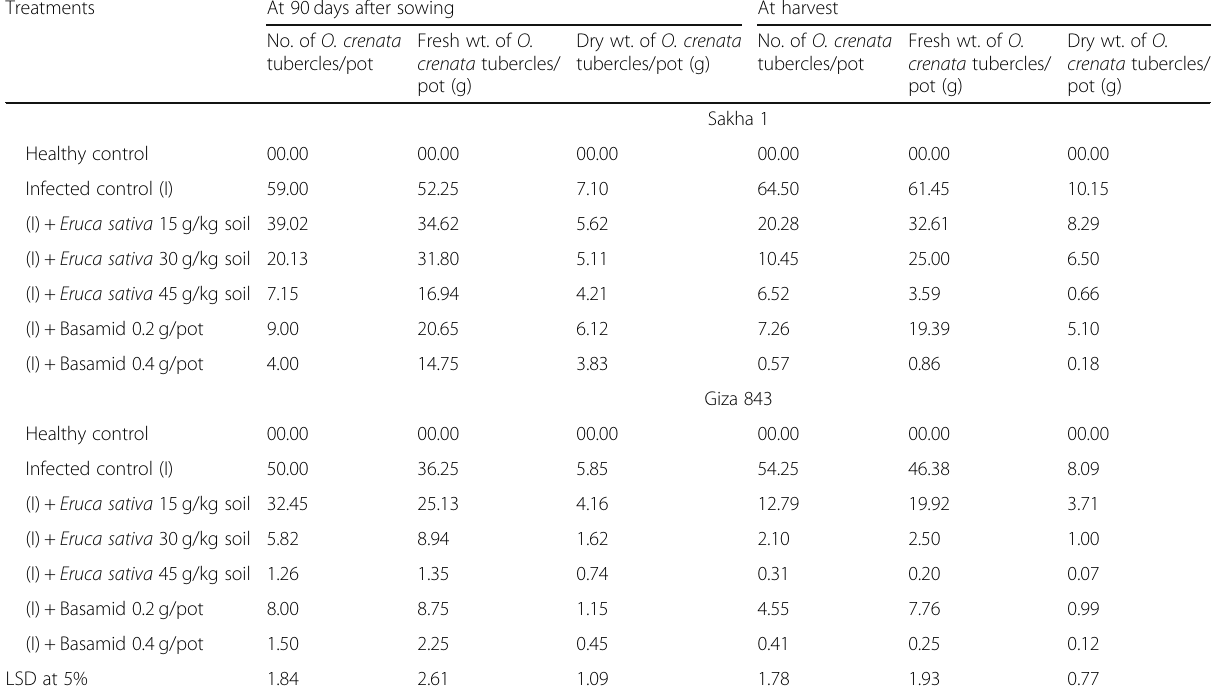
Table 1 Effect of different concentrations of Eruca sativa L. seed powder and Basamid herbicide on Orobanche crenata developed in two Vicia faba L. cultivars at 90 days after sowing and at harvest (combined analysis of two seasons) Treatments At 90 days after sowing At